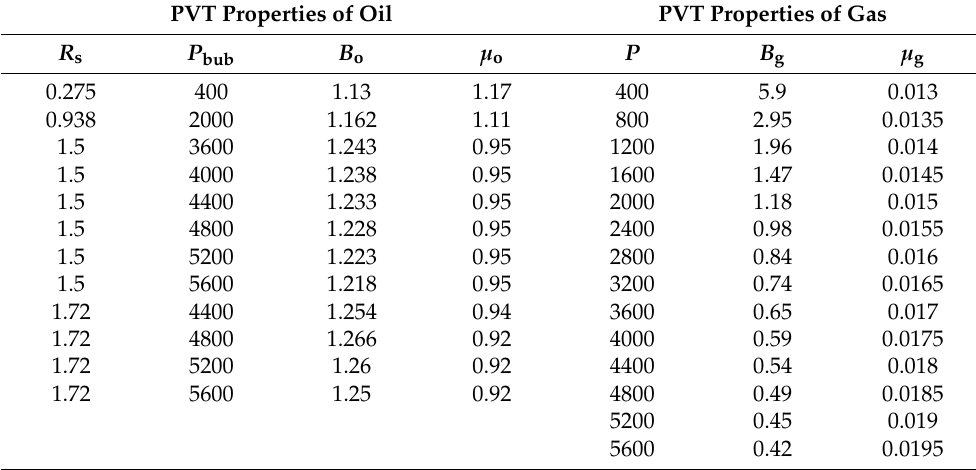
Table 3. PVT properties of oil and